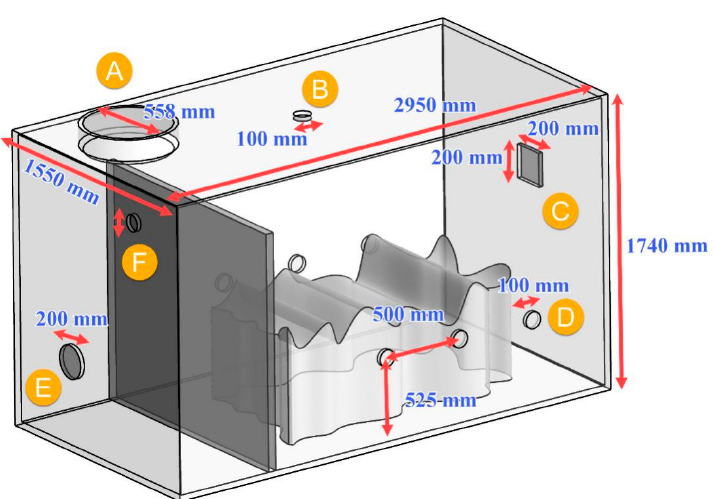
Figure 3. The created computational domain for doing combustion simulation of the portable incinerator